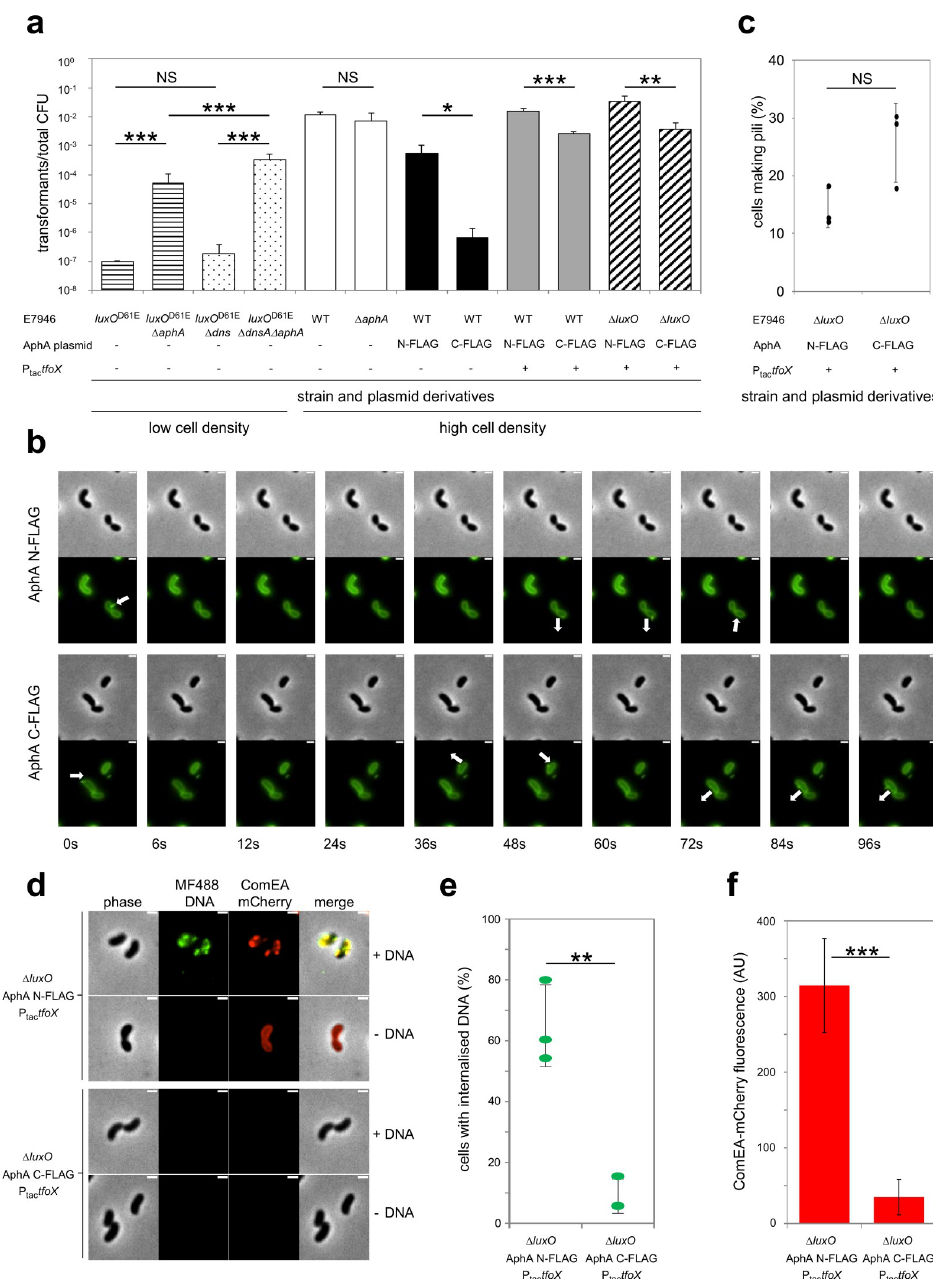
Fig 5. AphA represses DNA uptake in vivo by repressing expression of TfoX and ComEA. (a) Chitin-induced transformation assays at low or high cell density. The LuxO D61E derivative is constitutively active due to a phosphomimetic mutation that locks V . cholerae in a low cell density state. The dns gene encodes an endonuclease expressed at low (but not high) cell density to degrade DNA obtained by natural transformation. P tac - tfoX is a chromosomally integrated IPTG-inducible construct. Transformation reactions for strains with P tac - tfoX were supplemented with 100 μ M IPTG. Plasmid encoded N- (N-FLAG) or C-terminally (C-FLAG) tagged AphA was constitutively expressed in strains as indicated. Transforming DNA was an antibiotic resistance cassette that integrates in place of VC1807 encoding Erm R , Zeo R or Tet R . All data are from at least 4 independent biological replicates and P was calculated using a two-tailed Student’s t-test. Data were significant at � P � 0.05; �� P � 0.01 or ��� P � 0.001. (b) Pilus production was assessed by timelapse microscopy using cells labelled with AF488-mal. Data are representative of at least 3 independent experiments. White arrows indicate dynamic pilus events and arrow orientation indicates extension or retraction. The scale bar is 1 μ m. (c) Quantification of pilus dynamic activity (as shown in b) as